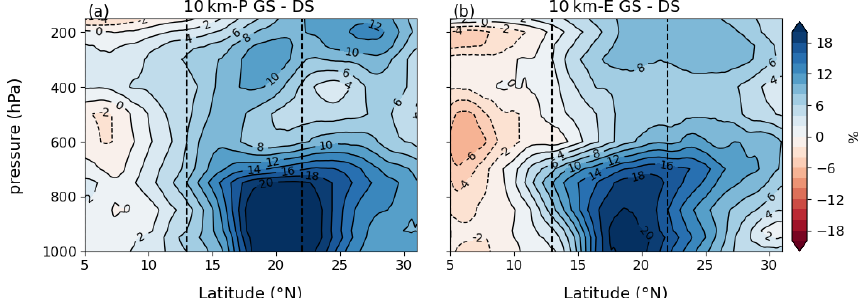
Figure B4. JAS mean meridional vertical cross section of relative humidity for the difference between the GS and DS simulation for the 10km-P (a) and the 10km-E (b) simulations. The average is calculated over the WA domain, and the vertical dashed lines indicate the boarders of the coastal, the Sahel, and the Sahara region outlined in Fig.